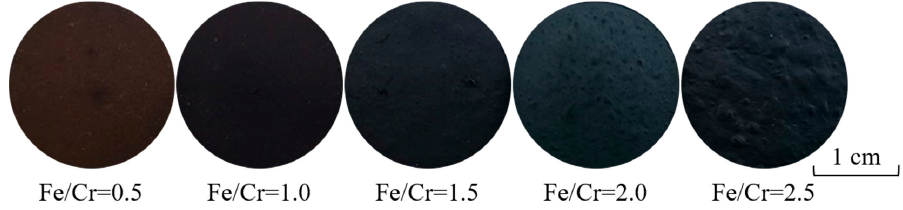
ff erent Fe / Cr molar ratio sintered at 1150 ◦ C for 30 Figure 3. Ceramic tile samples with different Fe/Cr molar ratio sintered at 1150 °C for 30 min. Figure 3. Ceramic tile samples with di